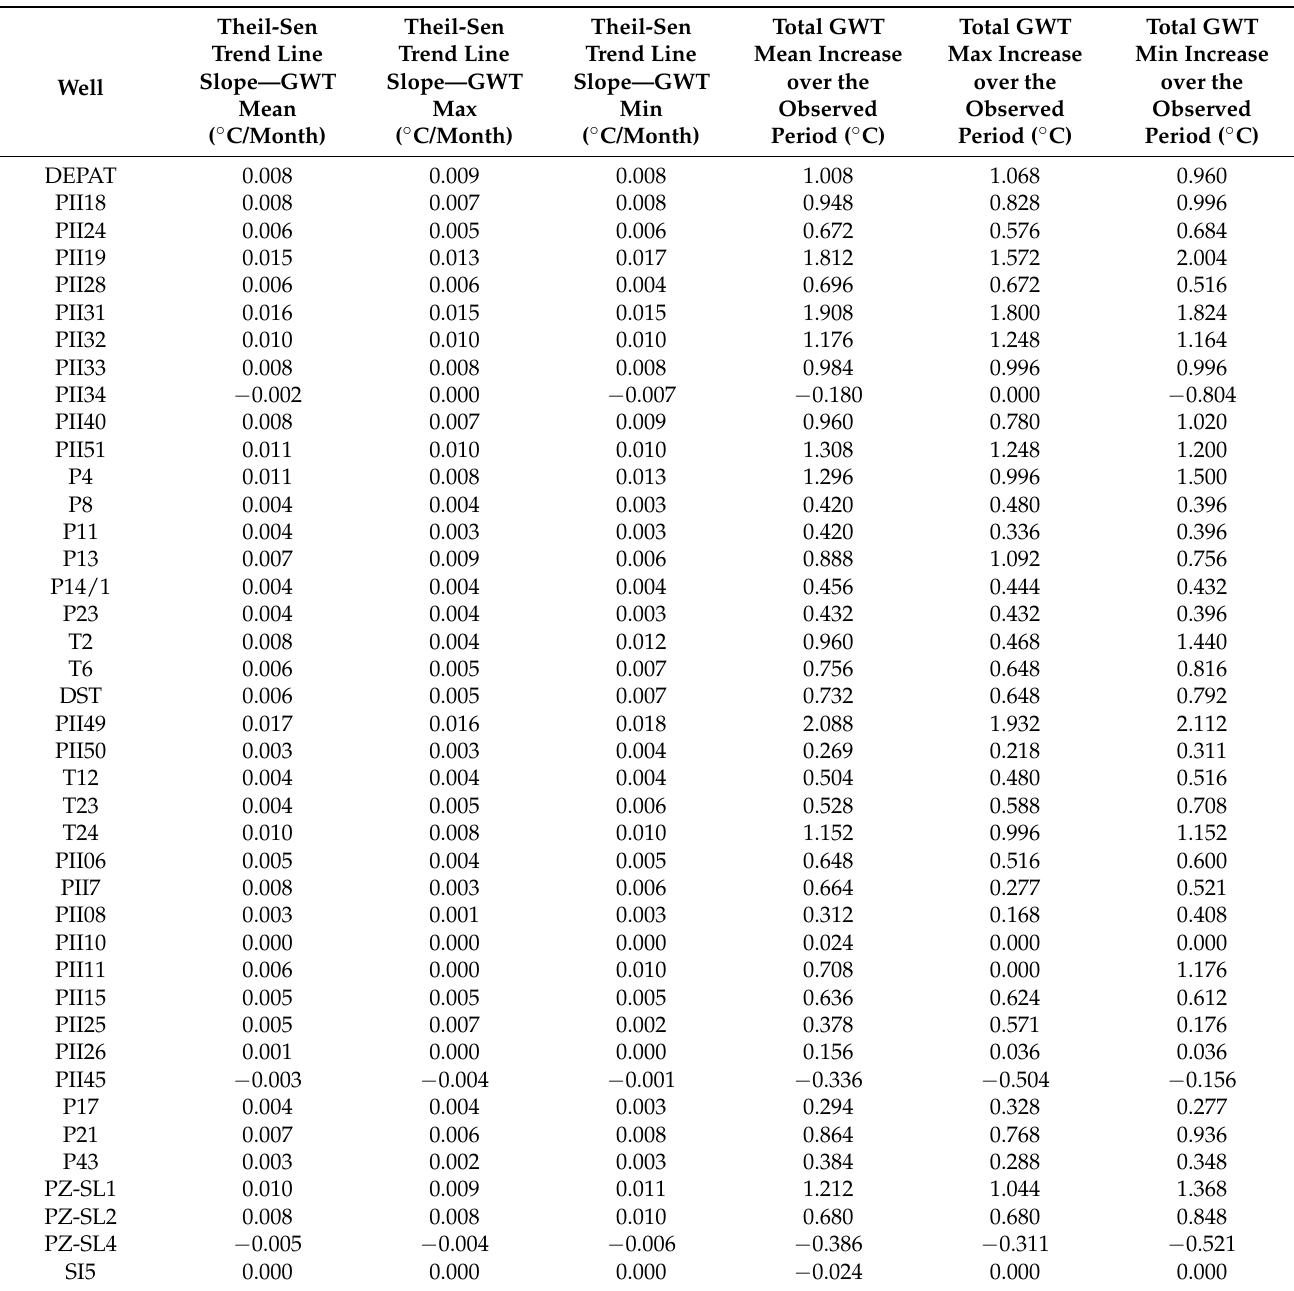
Table 4. Non-parametric tests analysis results about